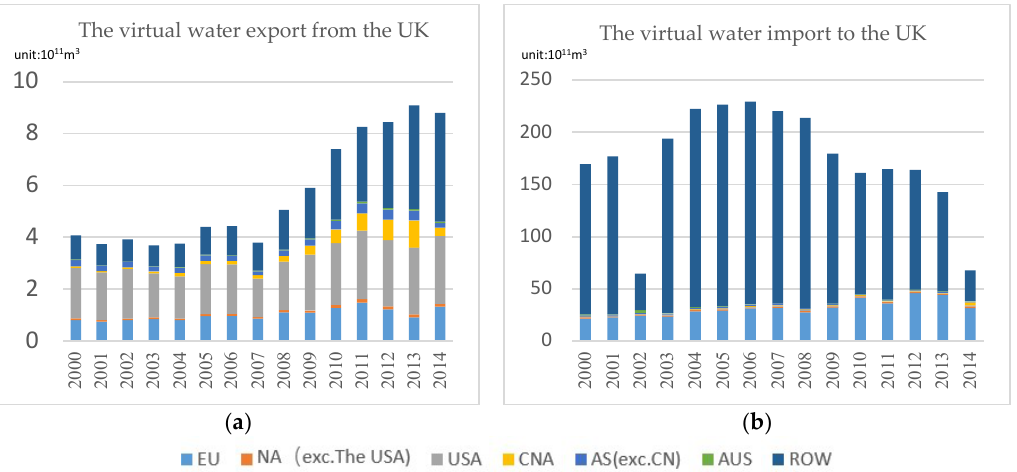
Figure 4. Virtual water exports (left)/imports (right) to/from the United Kingdom.